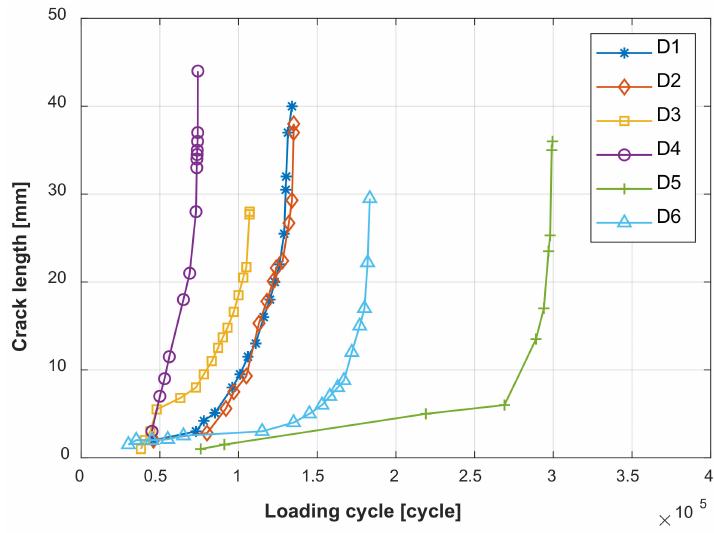
Figure 8. Total crack length versus fatigue loading